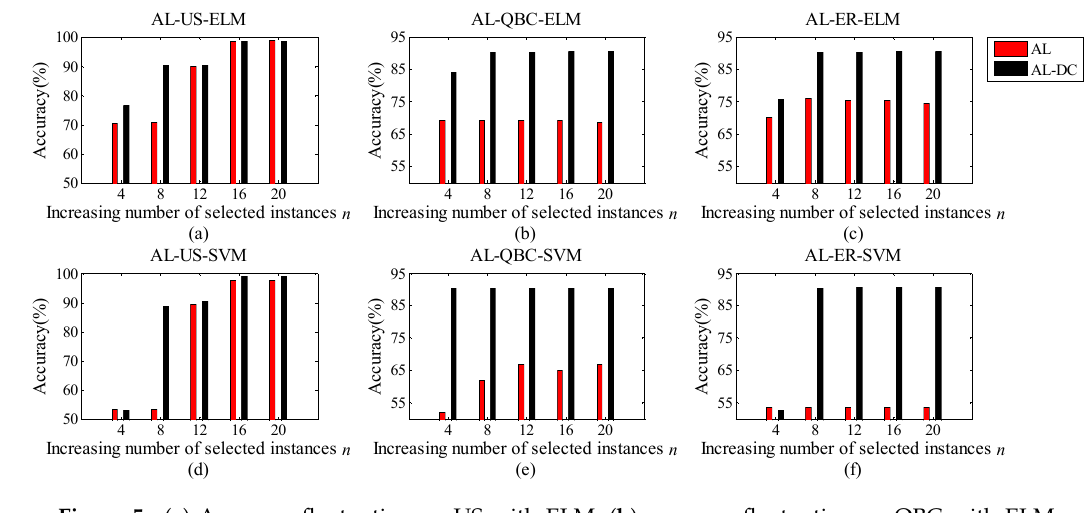
Figure 5. ( a ) Accuracy fluctuation on US with ELM; ( b ) accuracy fluctuation on QBC with ELM; ( c ) accuracy fluctuation on ER with ELM; ( d ) accuracy fluctuation on US with SVM; ( e ) accuracy fluctuation on QBC with SVM; ( f ) accuracy fluctuation on ER with SVM.